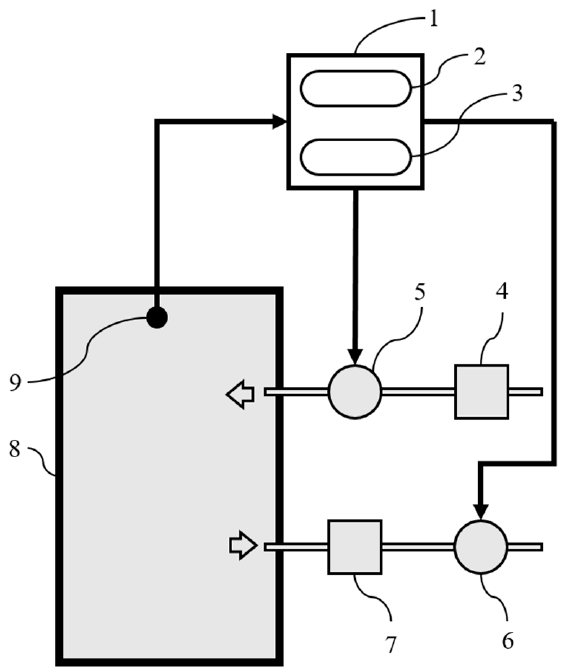
Figure 3. The structure of the air pressure compensation system with double fans. 1—Control device, 2,3—Frequency converter, 4,7—Filter, 5—Pressurizing fan, 6—Decompressing fan, 8—Elevator car, 9—Barometer.